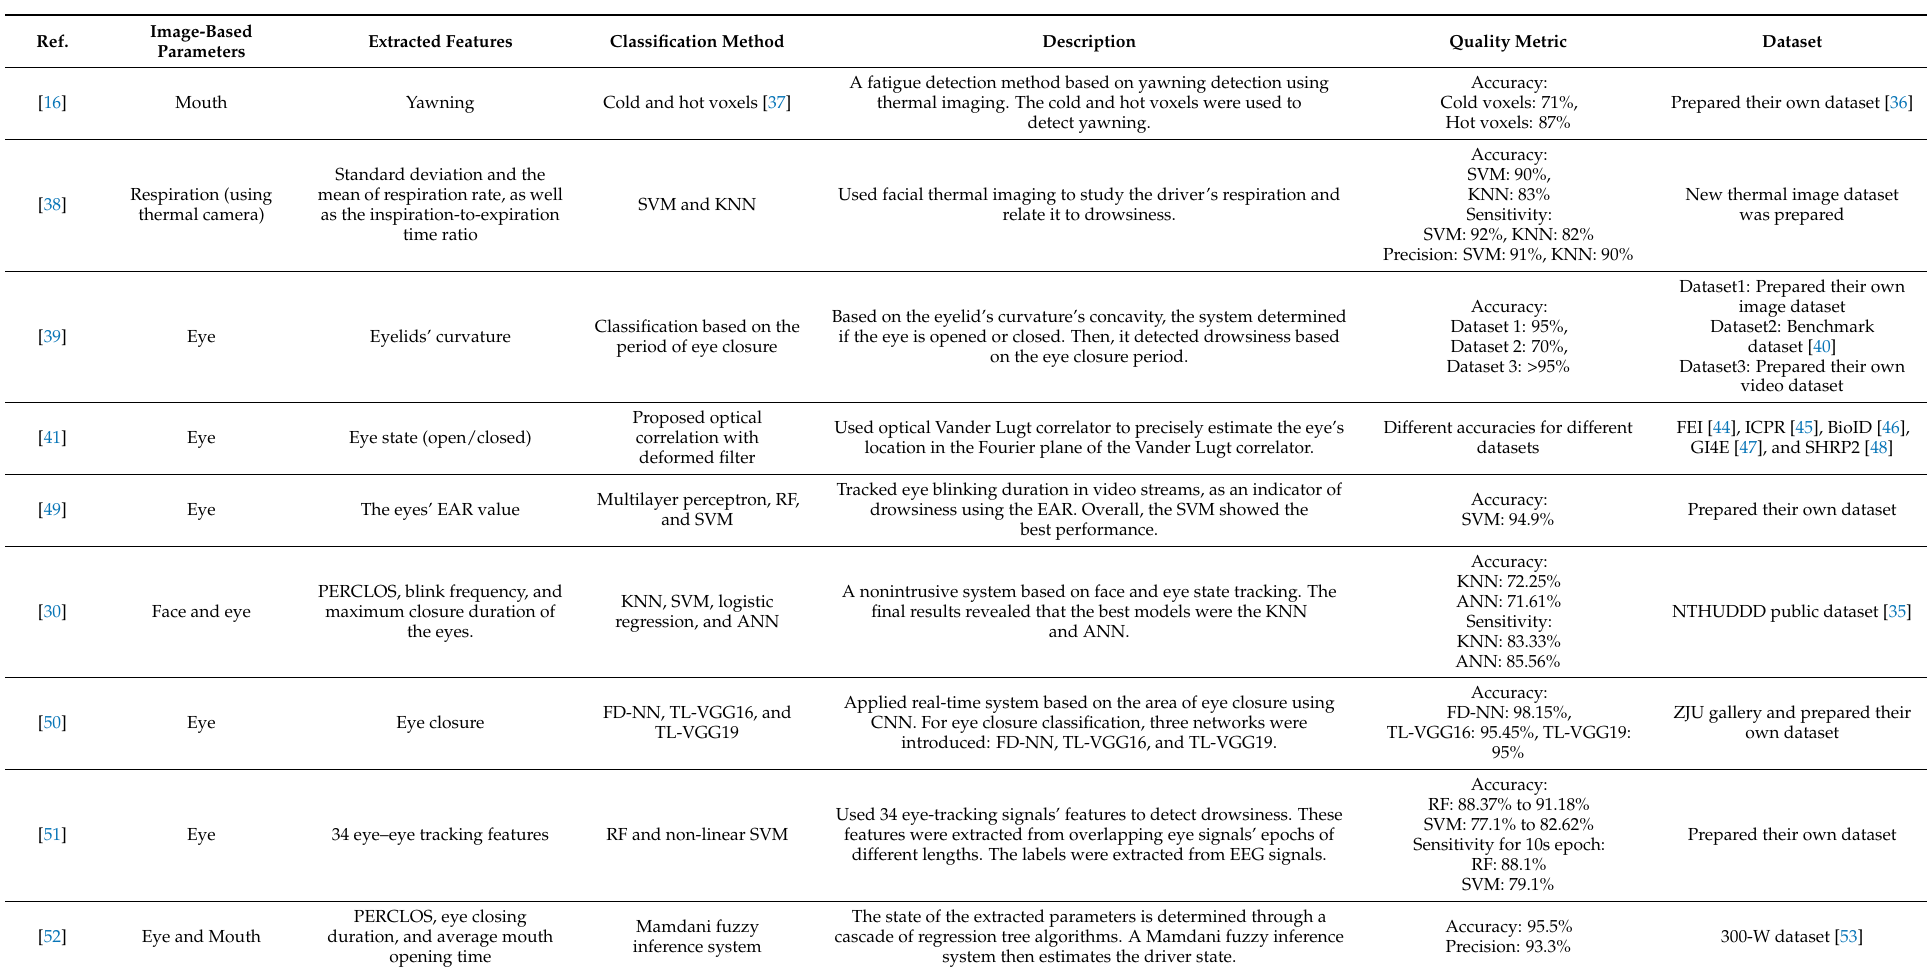
Table 4. Image-based drowsiness detection